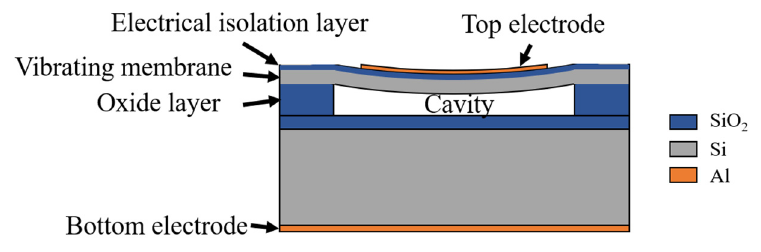
Figure 1. Cross-sectional view and components of a single cell of the proposed CMUT.